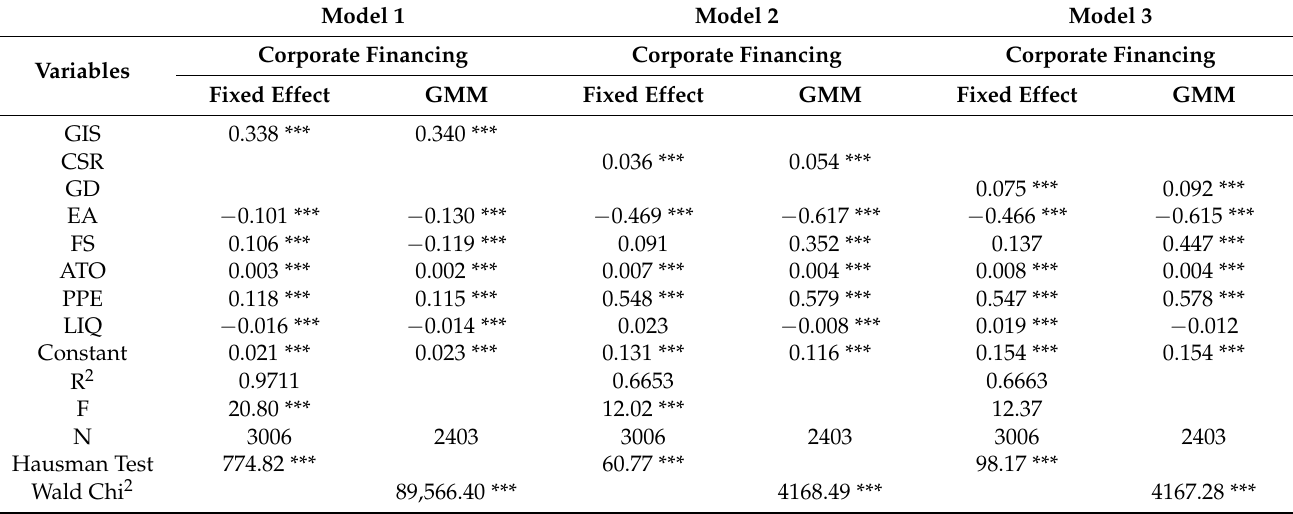
Table 2. Results of the link between GIS and CF, CSR and CF, GD and CF.